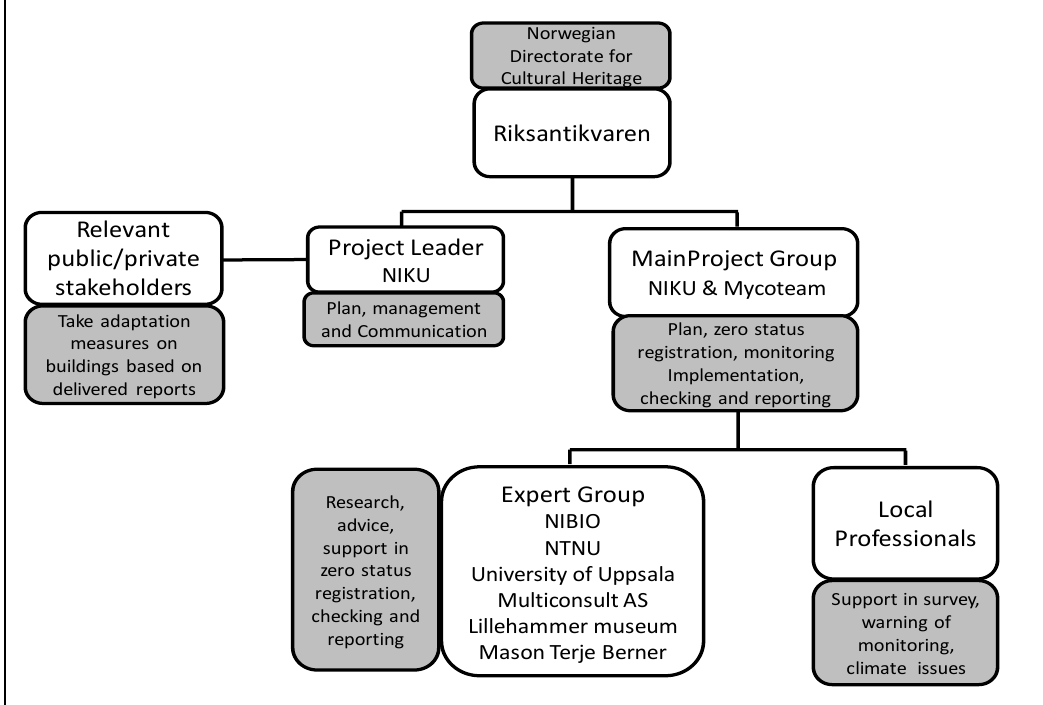
Figure 6. Organigram of the monitoring program: Environmental monitoring of the impact of climate